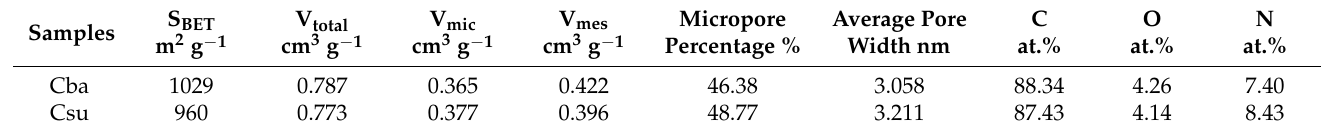
Table 1. Structural properties and elemental compositions of biomass carbon support.